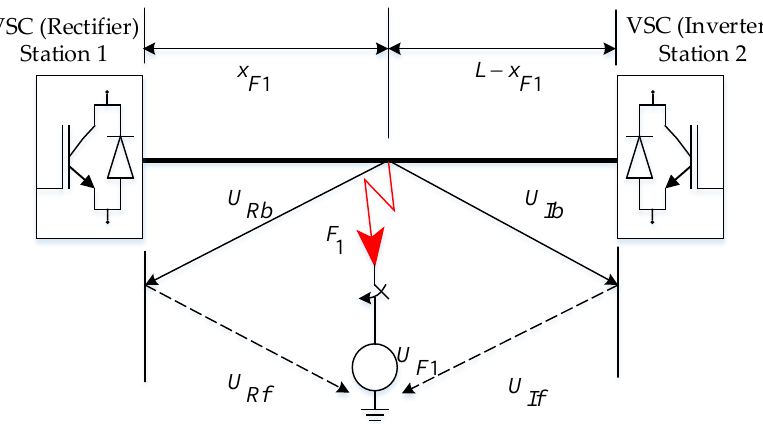
Figure 30. Propagation of traveling waves in case of internal fault. Appl. Sci. 2019 , 9 , x FOR PEER REVIEW